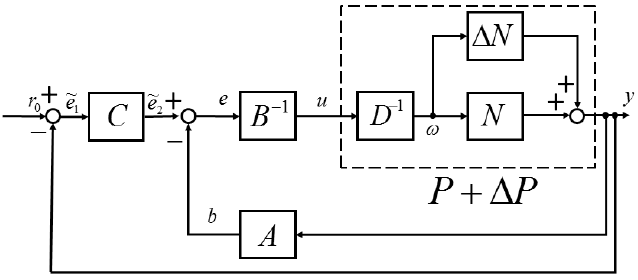
Figure 7. Nonlinear feedback control system with the tracking controller.